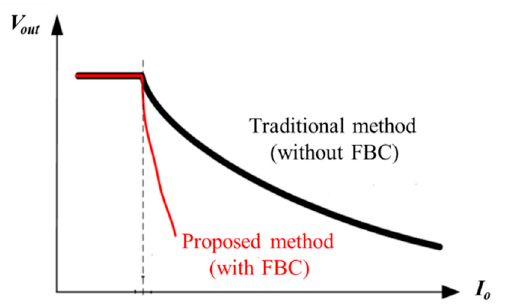
Figure 3. Waveform diagrams of a primary-side controlled flyback with FBC control working in DCM.